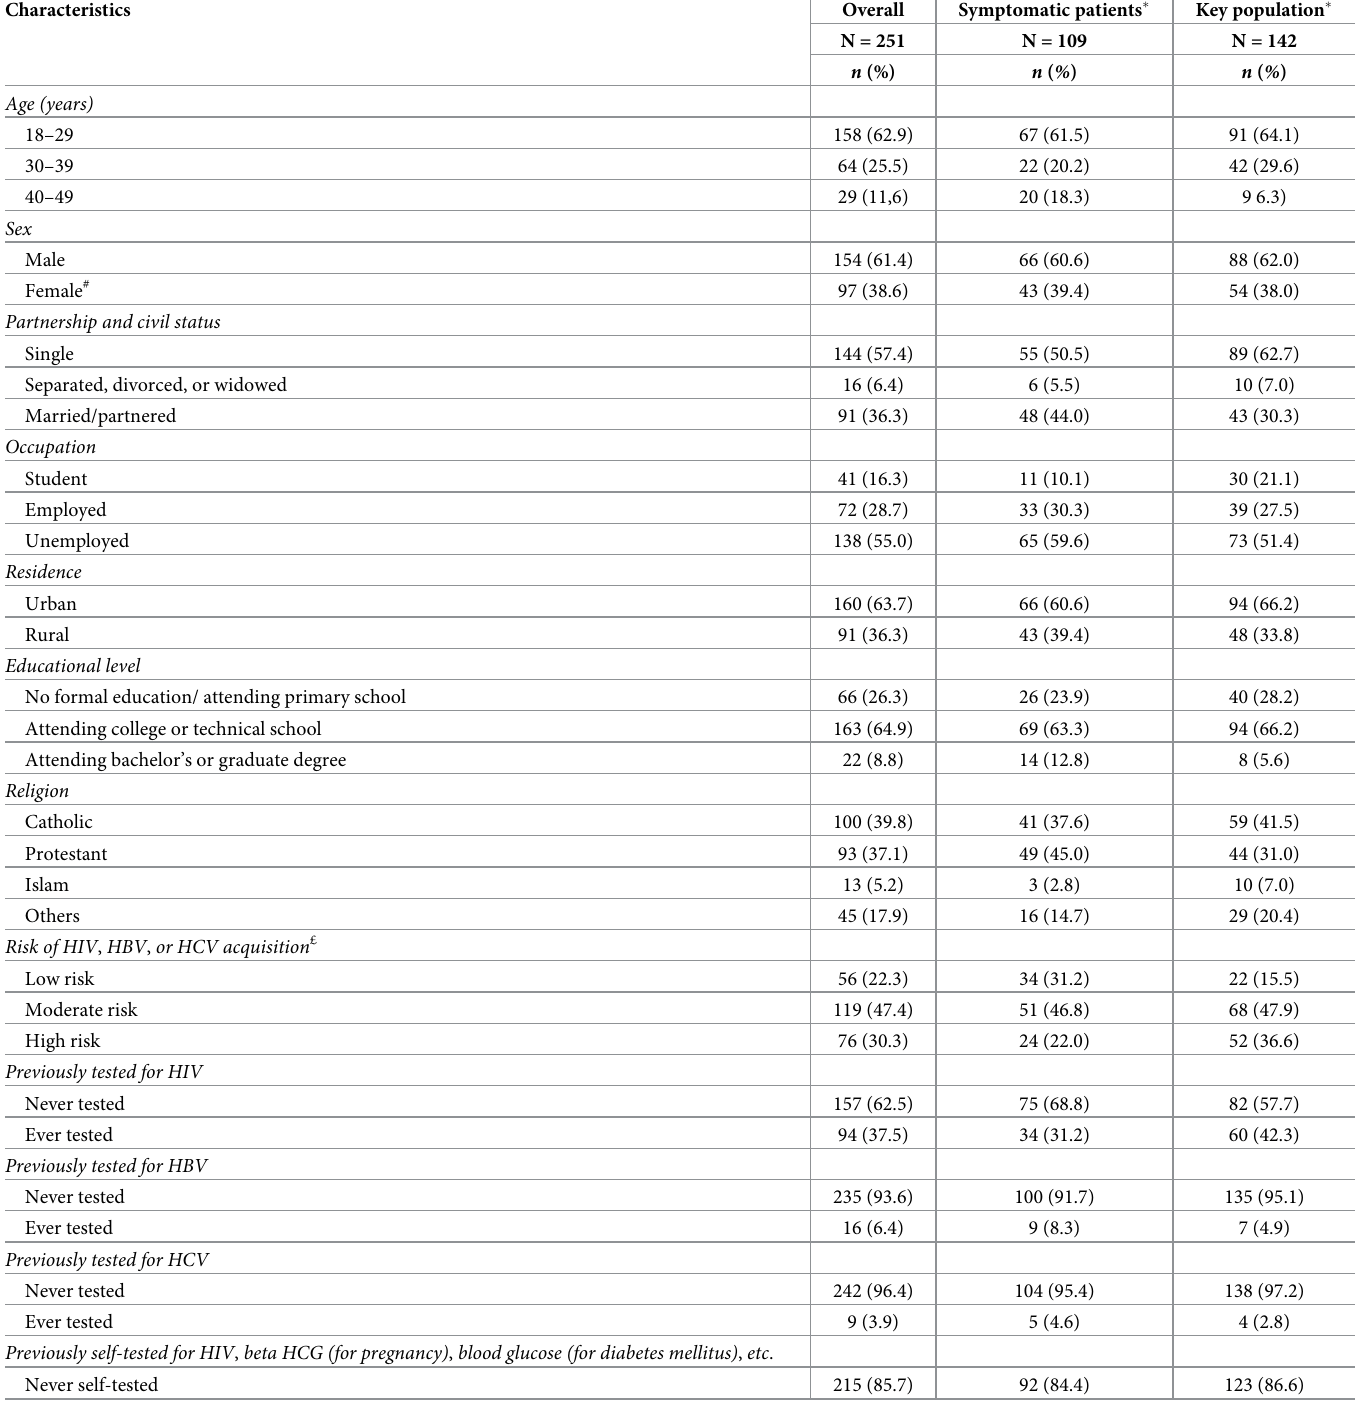
Table 1. The demographic characteristics and medical history of the 251 study participants.